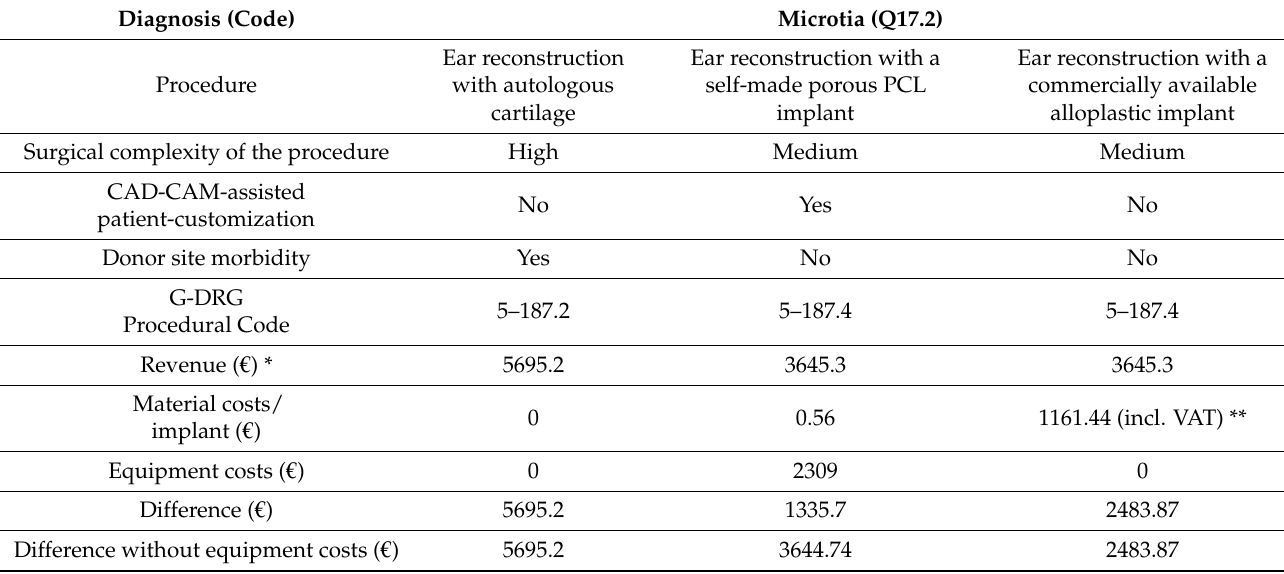
Table 1. Comparison between surgical procedures using different materials for ear reconstruction and the financial remu- nerations. The identical remunerations for different procedures in the G-DRG 2021 system does not display developmentary and material costs of medical implants. In-house production could offer a solution for this financial disbalance, while reducing the surgical complexity of the